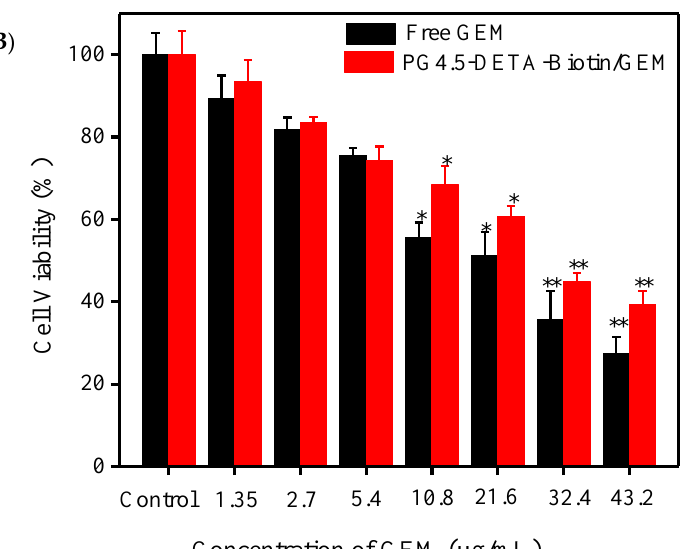
Figure 6. MTT assays to determine ( A ) Biocompatibility of PG4.5-DETA-biotin towards HaCaT and HeLa cells after 24 h ( n = 3). ( B ) Anti-proliferative effects of free GEM and PG4.5-DETA-biotin/GEM in HeLa cells after 24 h treatment. Results are mean ± SD of triplicate measurements ( n = 3). * P < 0.05 and ** P < 0.01 compared to control untreated cells.